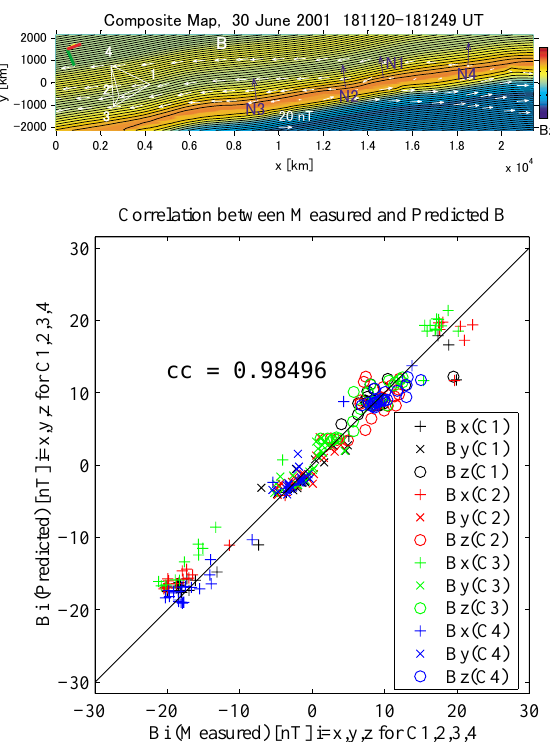
Fig. 8. Composite map and associated scatter plot for a magne- topause crossing on 30 June 2001, to which the single spacecraft- based GS reconstruction method has been applied in earlier work (Hasegawa et al., 2004). The spacecraft trajectories for this event are determined by sliding-window HT analysis, based on the data from C1 and C3, from which high time resolution measurements are available for both velocity and magnetic field. GSE coordinate axes of the map are x =(0.7857, 0.3953, 0.4757), y =(0.2985, − 0.9160, 0.2682), z =(0.5418, − 0.0687, − 0.8377).